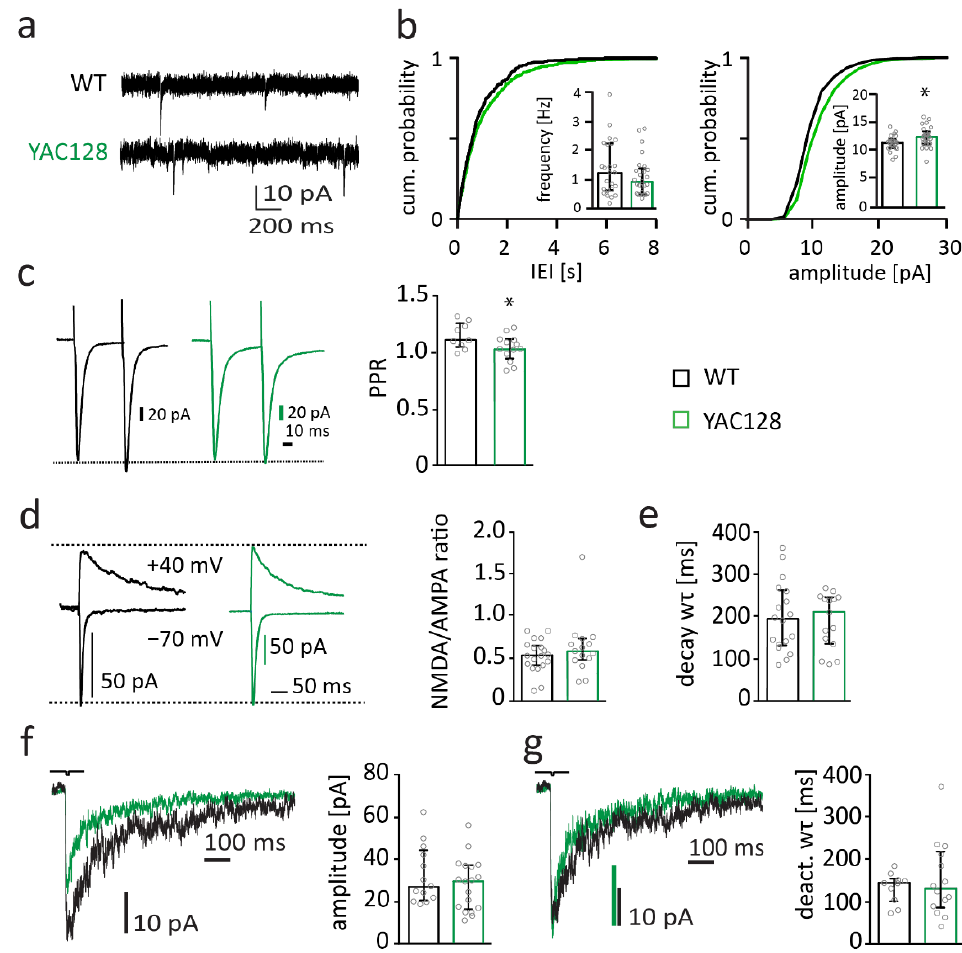
Figure 2. Synapse function is subtly changed in 12-month-old YAC128/BL6 mice. ( a ) Sample traces of miniature excitatory postsynaptic currents (mEPSC) recordings from MSNs of WT and YAC128/BL6 mice. ( b ) Cumulative distribution plot of AMPAR-mediated miniature excitatory postsynaptic currents (mEPSC) inter-event-intervals (IEIs) and amplitude. The inserts show bar graphs of the median mEPSC frequency and amplitude of MSNs from WT (black, n = 24) and YAC128/BL6 (green, n = 26) mice. ( c ) Sample traces of paired-pulse (PP) recordings from MSNs of WT (black) and YAC128/BL6 mice (green). Currents were evoked with an inter-pulse-interval of 50 ms. Bar graph of PP ratio (PPR) in MSNs of WT ( n = 9) and YAC128/BL6 ( n = 13) mice. ( d ) Sample traces of NMDAR- and AMPAR-mediated currents recorded at a holding potential of +40 mV and −70 mV, respectively. Bar graph of NMDA/AMPA ratio of MSNs from WT ( n = 19) and YAC128/BL6 ( n = 15) mice. ( e ) Bar graph of the weighted time constant (w τ ) of synaptic NMDAR-mediated current decays of MSNs from WT ( n = 18) and YAC128/BL6 ( n = 15) mice. ( f ) Sample traces of extrasynaptic NMDAR-mediated currents recorded from nucleated patches of MSNs and bar graph of median peak current amplitudes of MSNs from WT ( n = 13) and YAC128/BL6 ( n = 18) mice. ( g ) Peak-normalized sample traces of extrasynaptic NMDAR-mediated currents recorded from nucleated patches of MSNs and bar graph of the weighted time constant (w τ ) of current deactivation in nucleated patches of MSNs of WT ( n = 10) and YAC128/BL6 ( n = 14) mice. Bar graphs are depicted as median ± IQR. * = p < 0.05